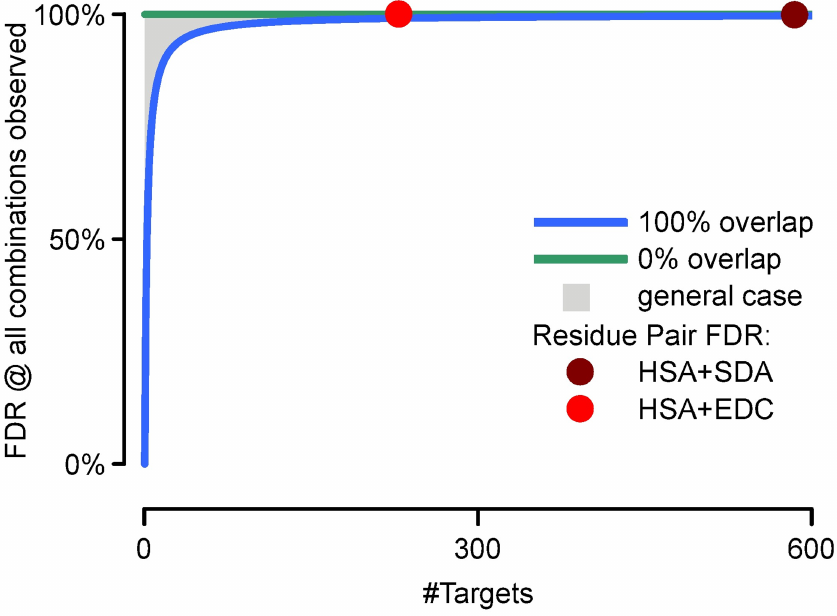
Fig 2. Maximal error from using formula 1. Maximal expected error when using formula 1, exemplified for the extreme case of every possible combination of links being observed. X-axis is the size of the database and Y-axis is the maximal error. The green and blue line give the border cases of 0% overlap for both sides of the cross-linker and 100% overlap respectively. The gray area represents possible errors for all cross-linker with partial overlap. Residue-level for HSA cross-linked SDA (dark red dot) and HSA cross-linked with EDC (light red dot) are given as reference.